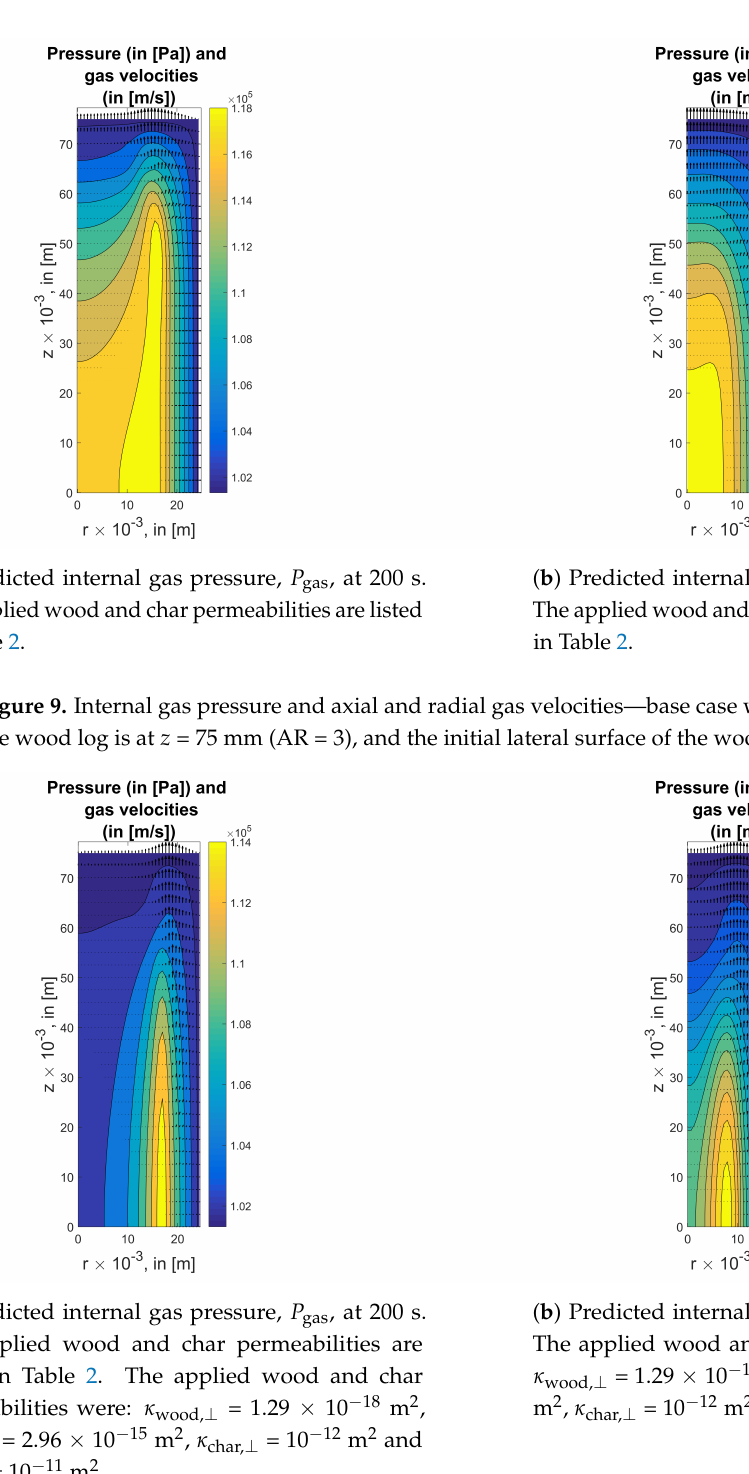
Figure 10. Internal gas pressure and axial and radial gas velocities. The top of the wood log is at z = 75 mm (AR = 3), and the initial lateral surface of the wood log is at r = 25